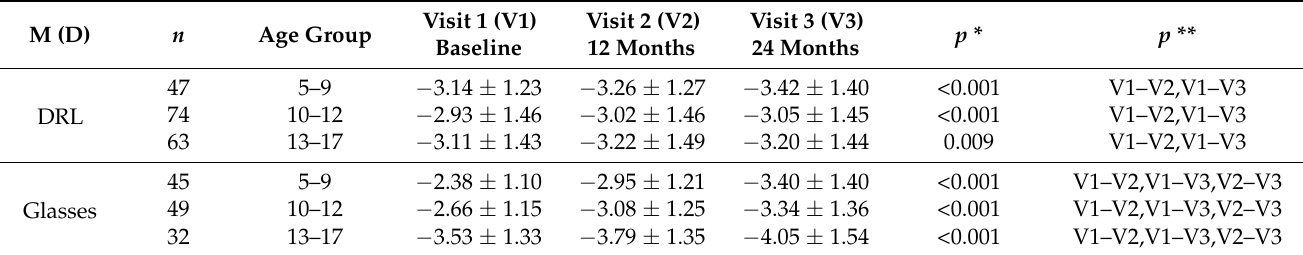
Figure 2. Myopia progression retention rate values for the M component after 12 months and after 24 months of treatment between treatments.